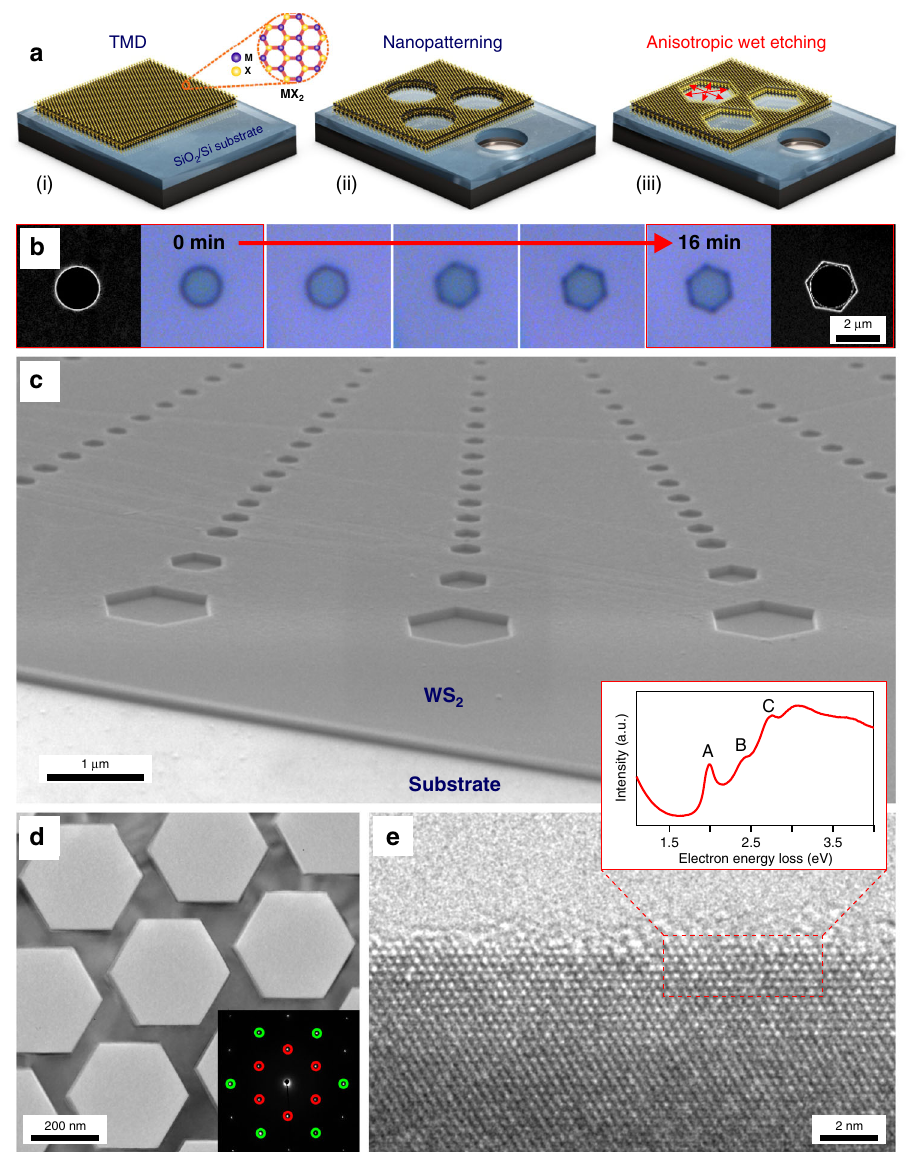
Fig. 1 Etching hexagonal nanostructures in TMD materials. a Schematic of the fabrication method: (i) transfer of a mechanically exfoliated TMD fl ake on a SiO 2 /Si substrate, (ii) nanopatterning of the transferred fl ake using standard top-down lithography, and (iii) anisotropic wet etching of the pre-patterned fl ake by water solution of hydrogen peroxide and ammonia. b Time-resolved anisotropic wet etching for a single hole in a WS fl ake. Leftmost 2 multilayer and rightmost panels show SEM images of the hole after 0 min and 16 min of etching, respectively. c 70° tilted SEM image of anisotropically etched WS 2 fl ake, revealing hexagonal holes and their orientation. d TEM image of an etched WS 2 hexagonal array. The inset shows a selected area electron diffraction pattern from the imaged area, revealing a single crystalline WS 2 diffraction pattern along a [0001] zone axis with an orientation that con fi rms the etched surfaces are aligned with the zigzag-terminated direction. The red and green circles identify the 1100 and 1120 families of diffraction spots, respectively. e HRTEM image of an etched surface, revealing its nearly atomically sharp zigzag nature. The inset shows a scanning TEM (STEM) EELS spectrum acquired with the electron probe positioned directly at the etched zigzag surface, revealing the presence of strong A-, B-, and C-exciton